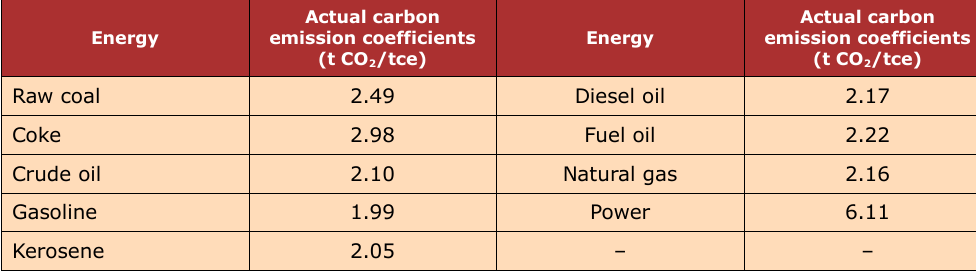
Table 1. Actual Carbon Emission Coefficients of